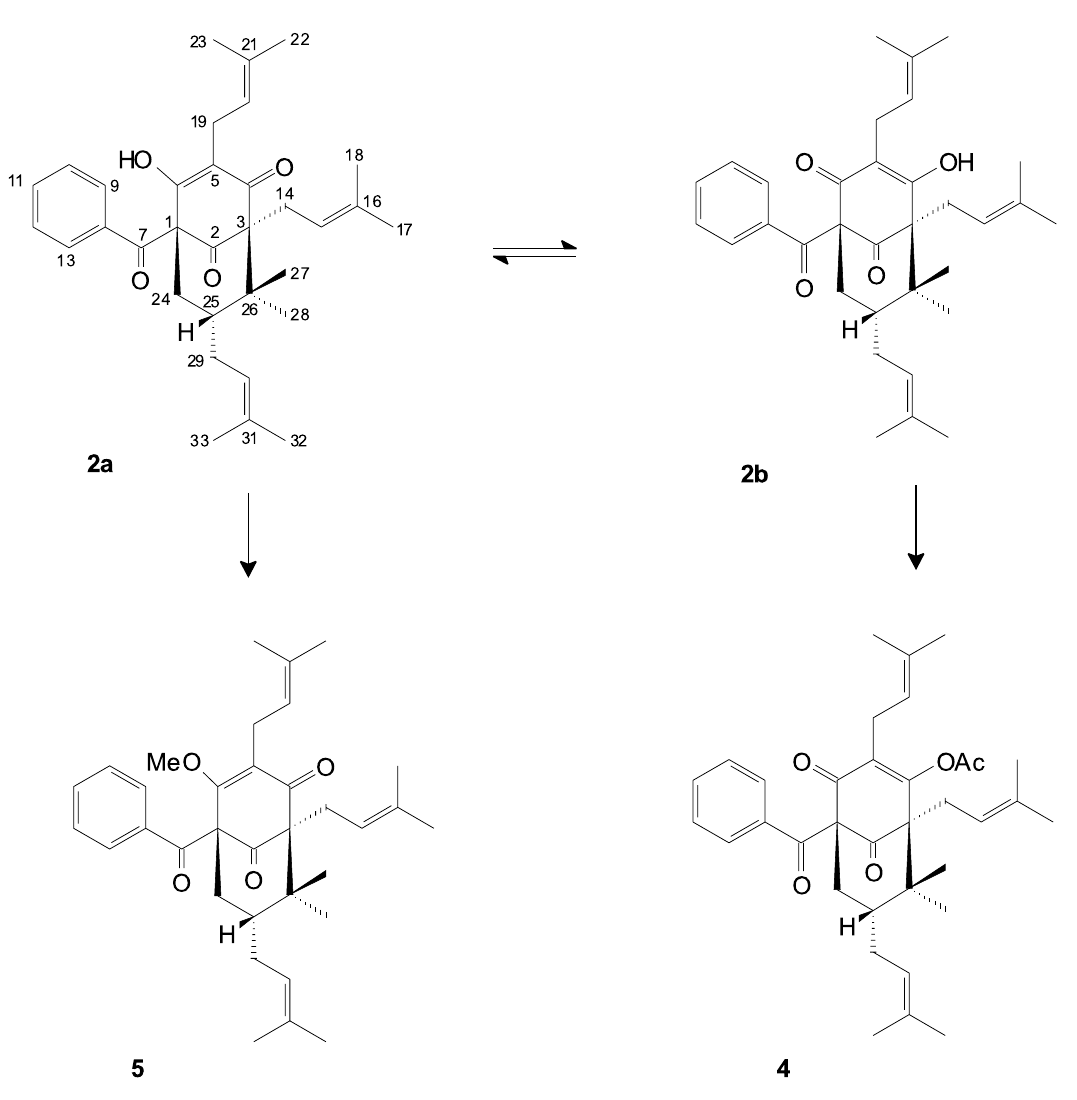
Fig. 2 – Structures of nemorosoneA ( 2a ) and its methyl ether ( 5 ) derivative, and of nemorosone B ( 2b ) and its monoacetate derivative ( 4